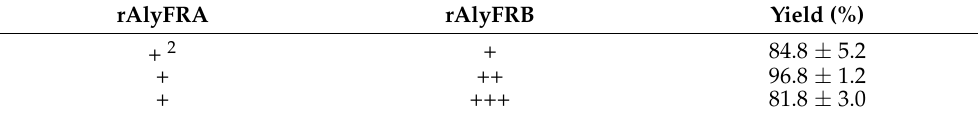
Table 1. DEH 1 yield.